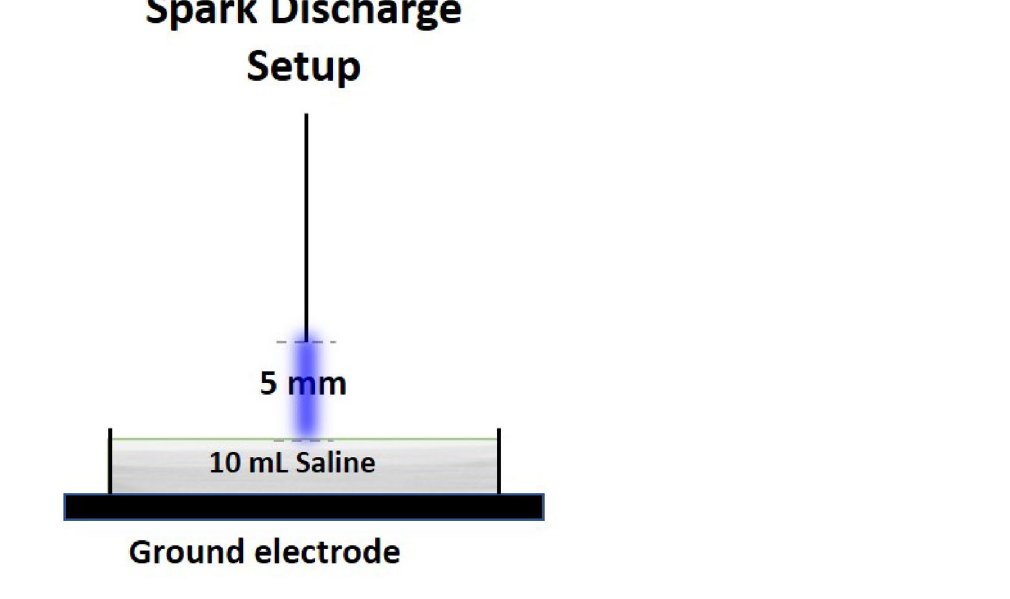
Figure 1. Spark discharge setup